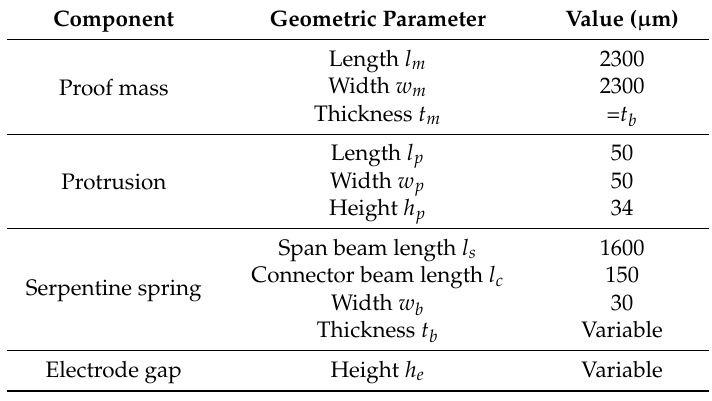
Table 2. Main geometrical parameters of the designed switch.